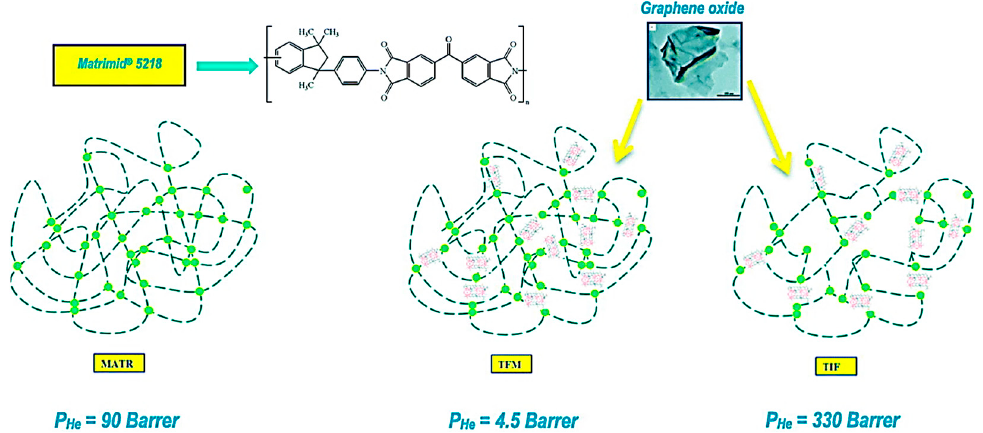
Figure 12. Possible configurations of graphene oxide nanofiller in polyimide membrane [126]. MATR = Matrimid ® 5218; TFM = thin film membrane; TIF = thick isotropic film. Reproduced with permission from Elsevier.